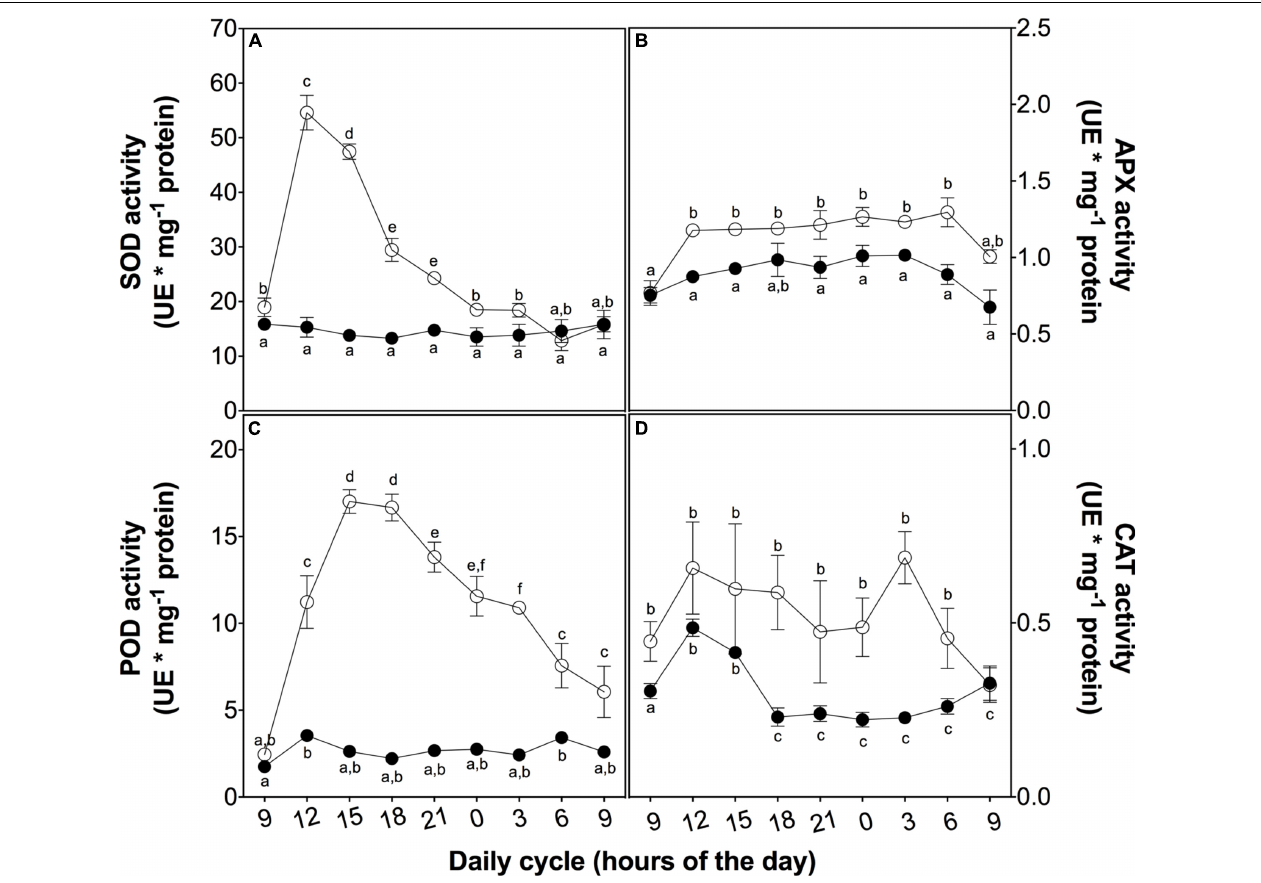
FIGURE 4 | Antioxidant enzyme activity in D. antarctica plants exposed to UVB radiation and control conditions. Superoxide dismutase activity (A) , ascorbate peroxidase activity (B) , the total activity of peroxidases (C) and catalase activity (D) is observed. Open circles represent means ( ± standard error of the mean; N = 3) of plants that underwent the UVB treatment and closed circles represent the control means ( ± standard error of the mean; N = 3). Significant differences between treatments are indicated by letters ( ∗ P <